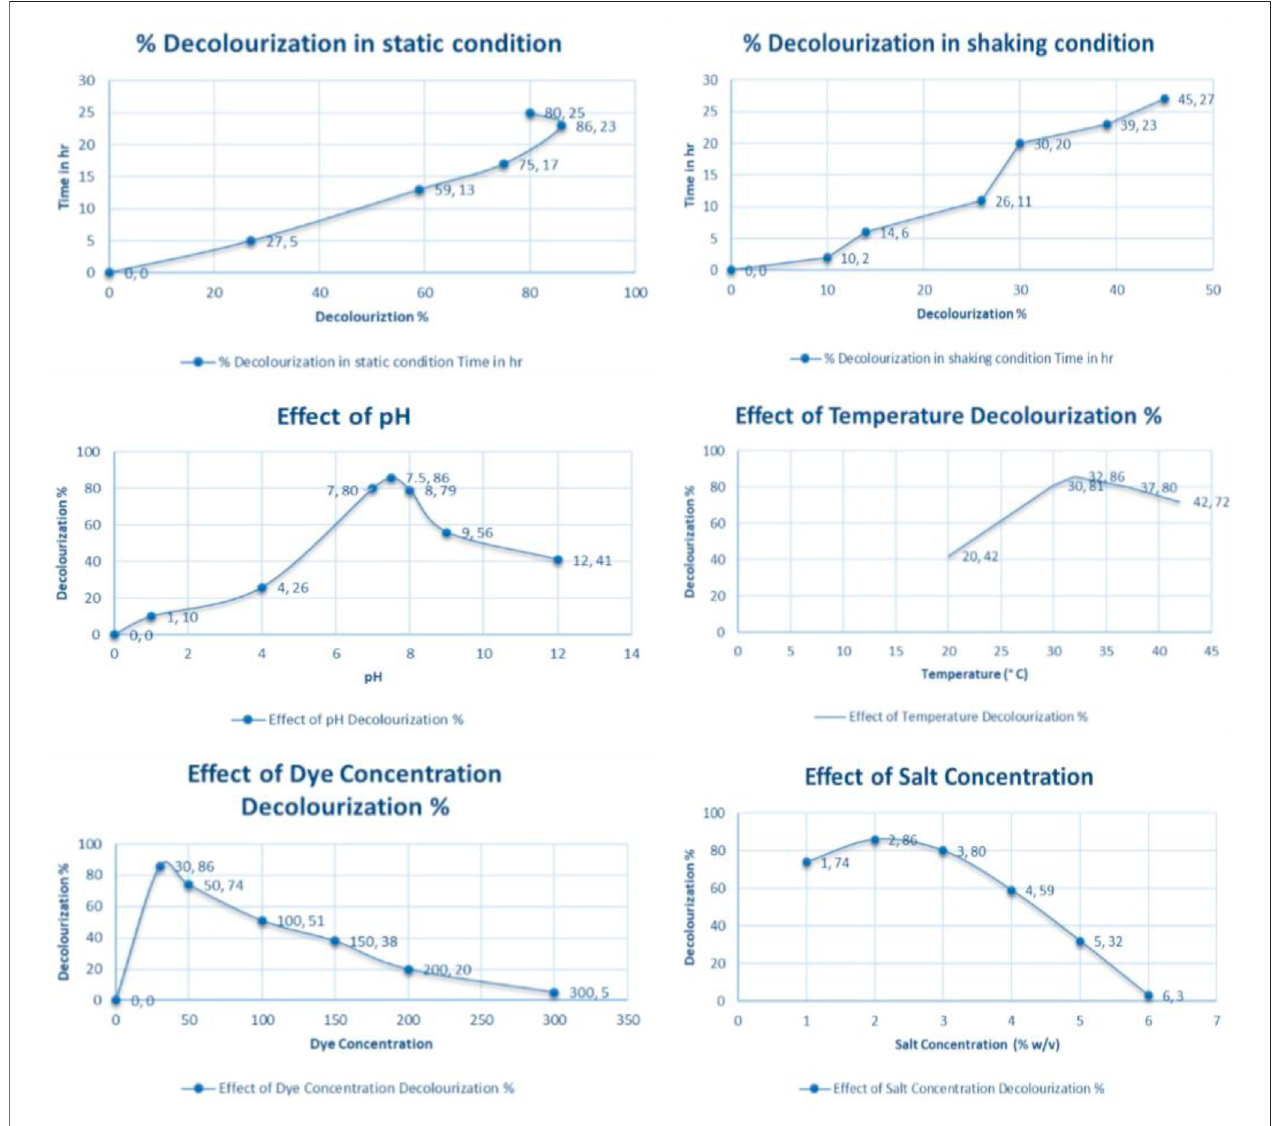
FIGURE 2 | Effect of Environmental factors on decolorization